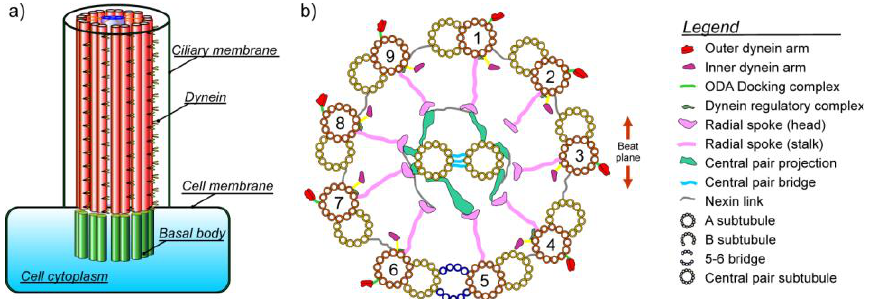
Figure 1. ( a ) Cylindrical architecture of the flagellum with nine microtubule doublets forming the axoneme; ( b ) cross section of axoneme. The figure shows the main ingredients; nine microtubule doublets, the central microtubule pair, radial spokes, nexin linkers, and two sets of different dynein motors (outer dynein arms and inner dynein arms). Some accessory proteins are also added [2].